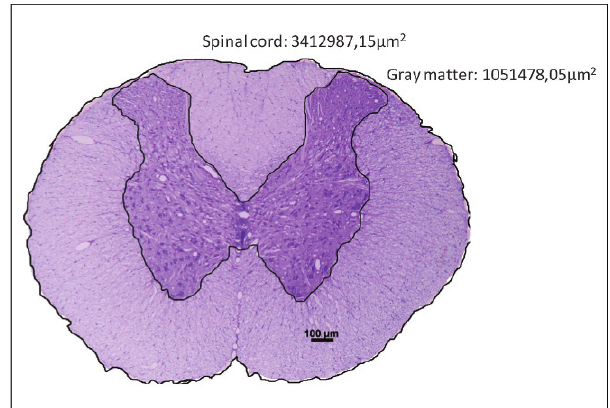
Figure 2 - Sham spinal cord transverse slice, 7 m m thick, with indication of total spinal cord and gray matter areas ( m m 2 ). The white matter area was calculated by subtracting gray matter area of the total spinal cord